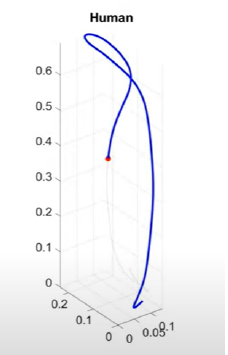
Figure 12. Snapshot of test